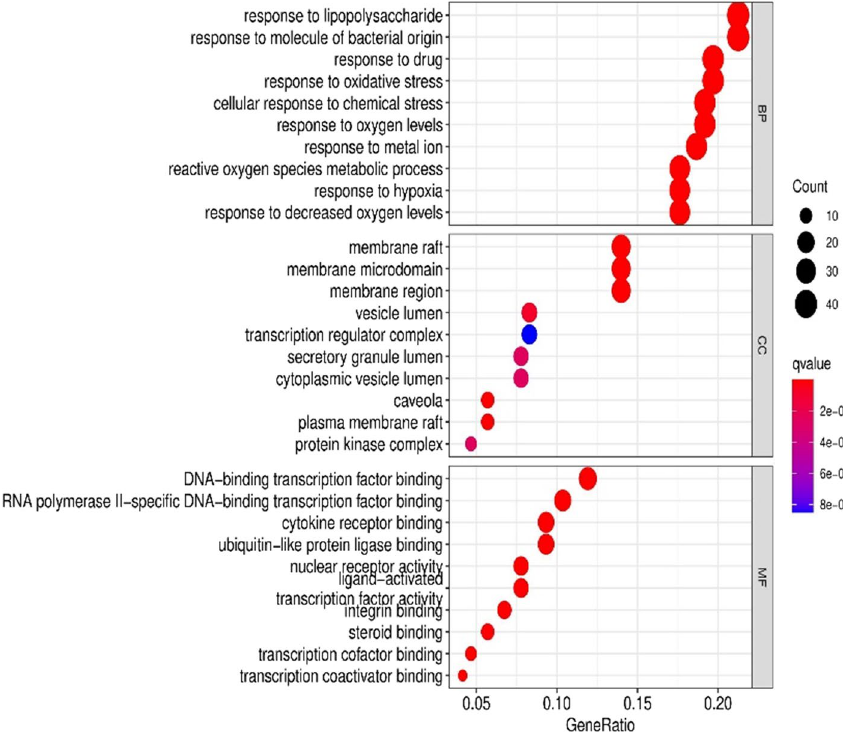
Figure 4. The GO enrichment analysis of core nodes. Including cellular components, molecular functions, biological processes.